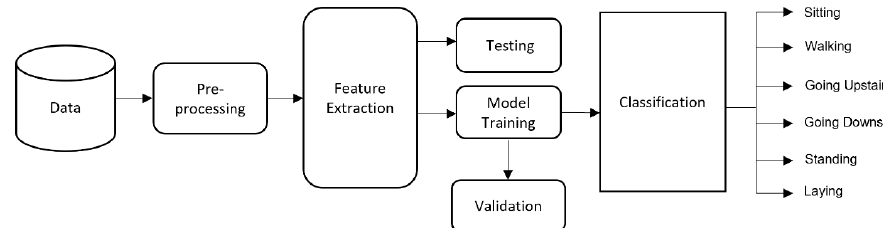
Figure 1. Conventional machine learning architecture for human activity